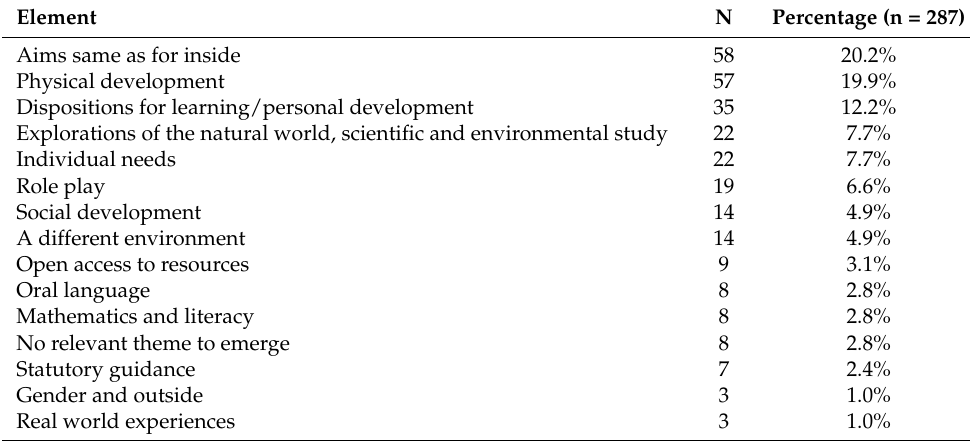
Table 1. English sample. Elements arising from analysis of ‘aims’ question and associated % of coded